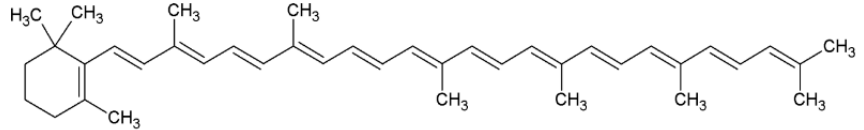
Figure 4. The structural formula of